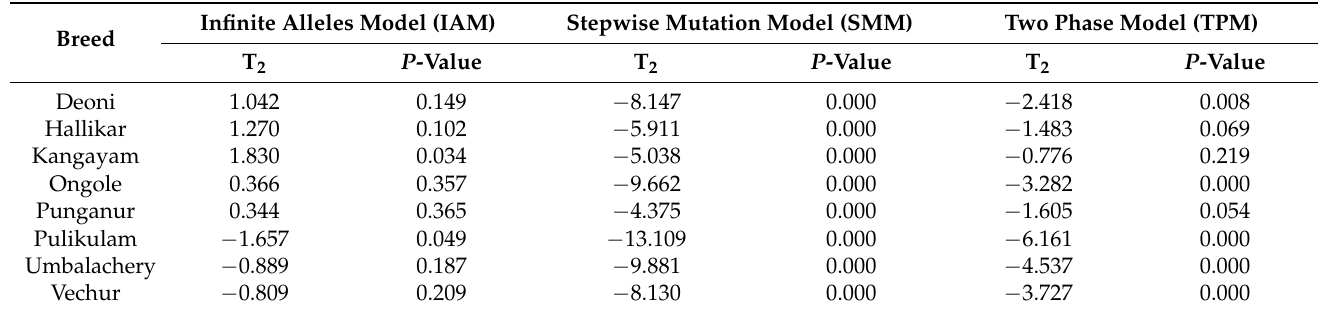
Table 3. Standardized differences test to evaluate zebu cattle breeds for mutation drift equilibrium under different models.